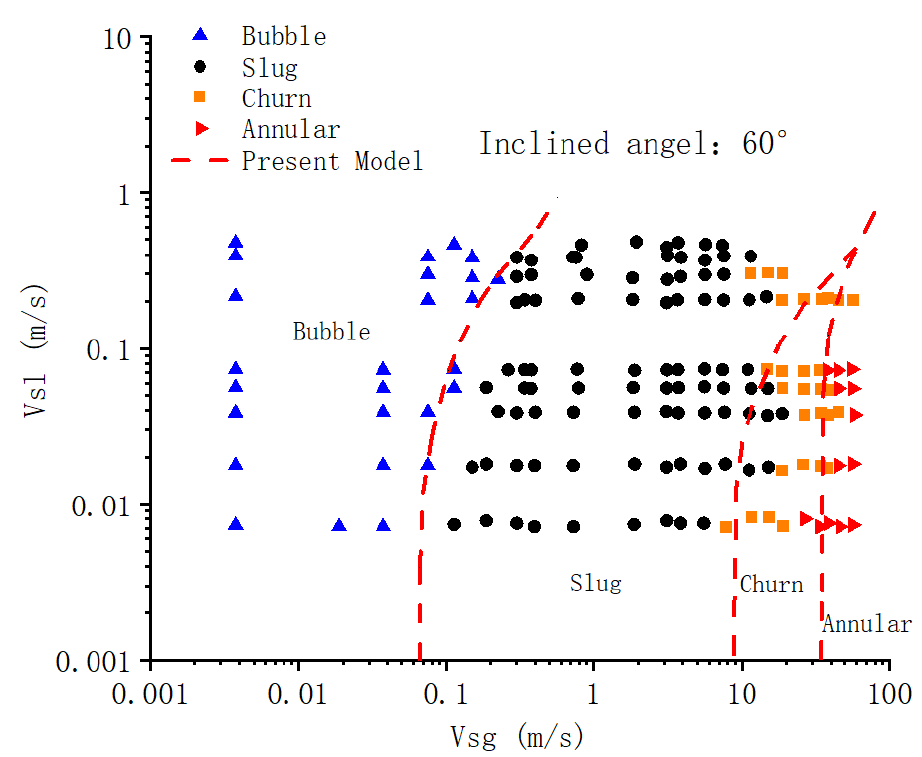
Figure 12. Flow pattern distribution of gas-liquid two-phase flow in the annulus pipe at an inclination angle of 60°.